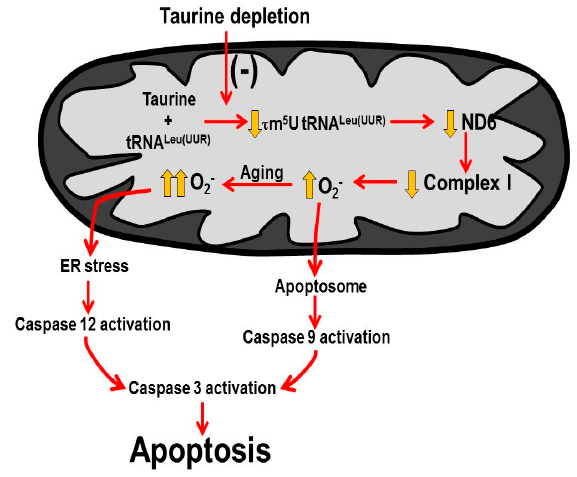
Figure 8. Mechanisms underlying taurine deficiency-mediated myocardial cell death.